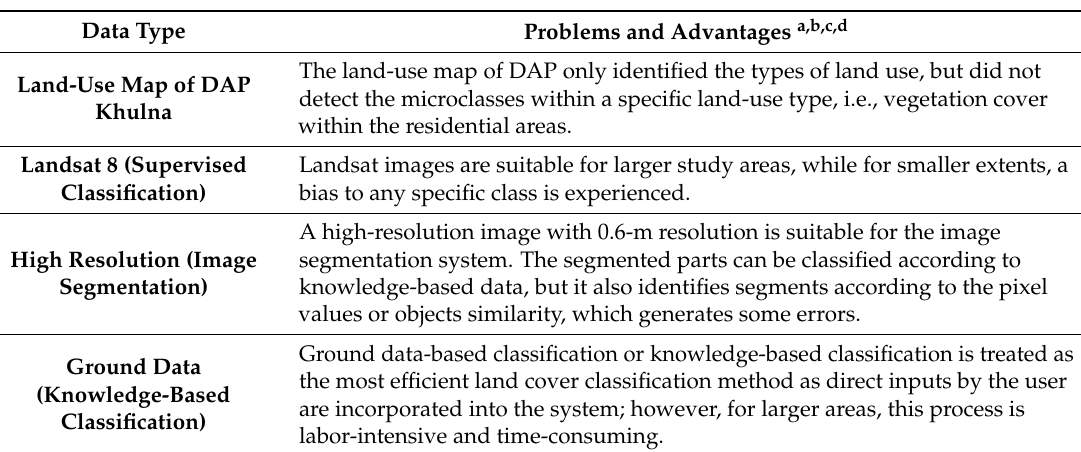
Table 3. Problems and advantages of different data types and image classifications.